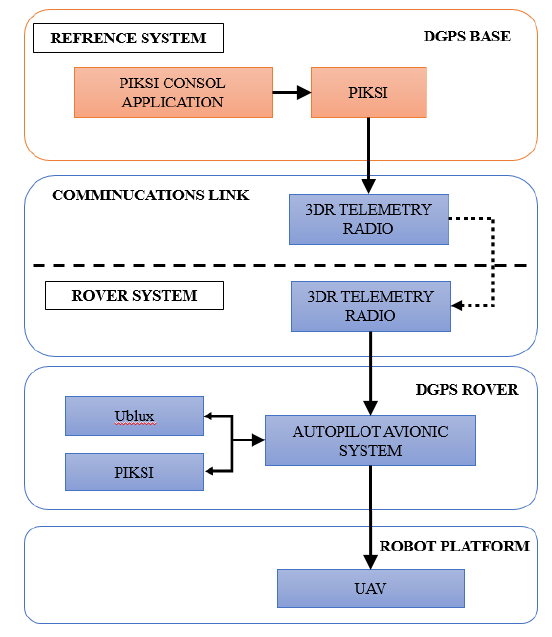
Figure 2: UAV avionic with